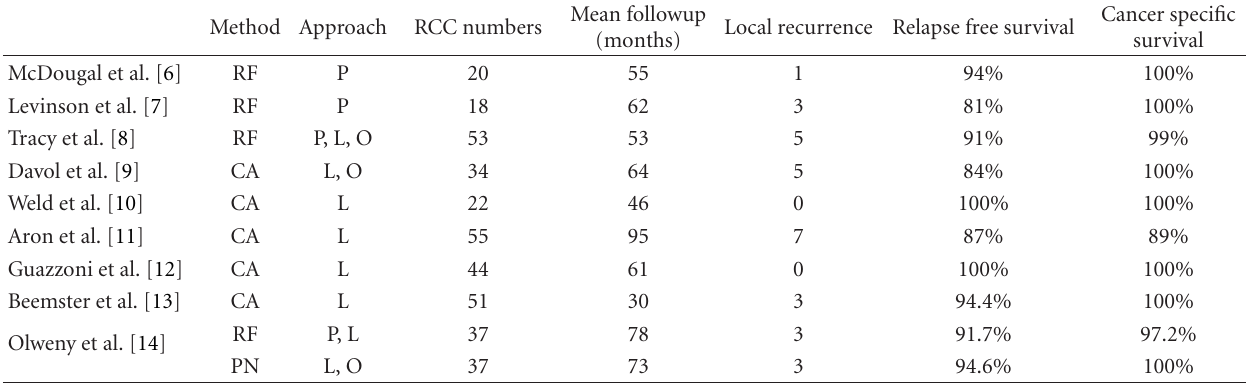
Table 1: Mid- to long-term results of cryoablation (CA) and radiofrequency (RF), and one group compared the results between radiofrequency and partial nephrectomy